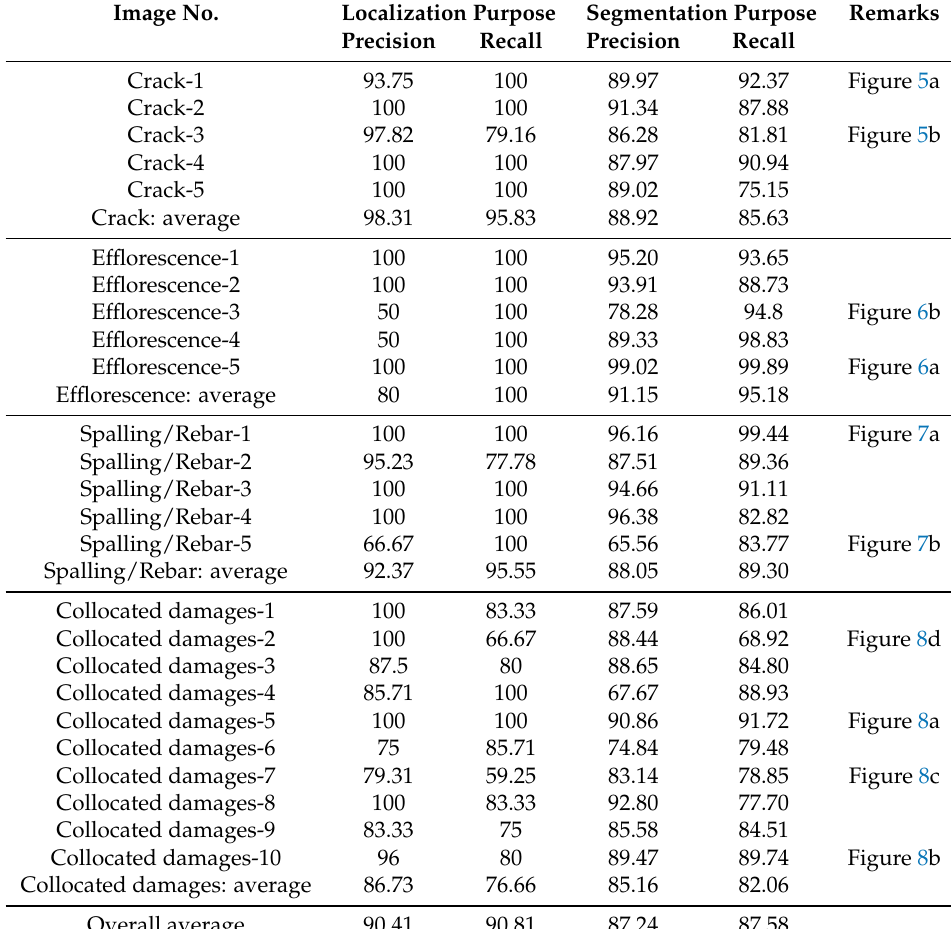
Table 1. Evaluation results for trained Mask R-CNN for multiple concrete damage